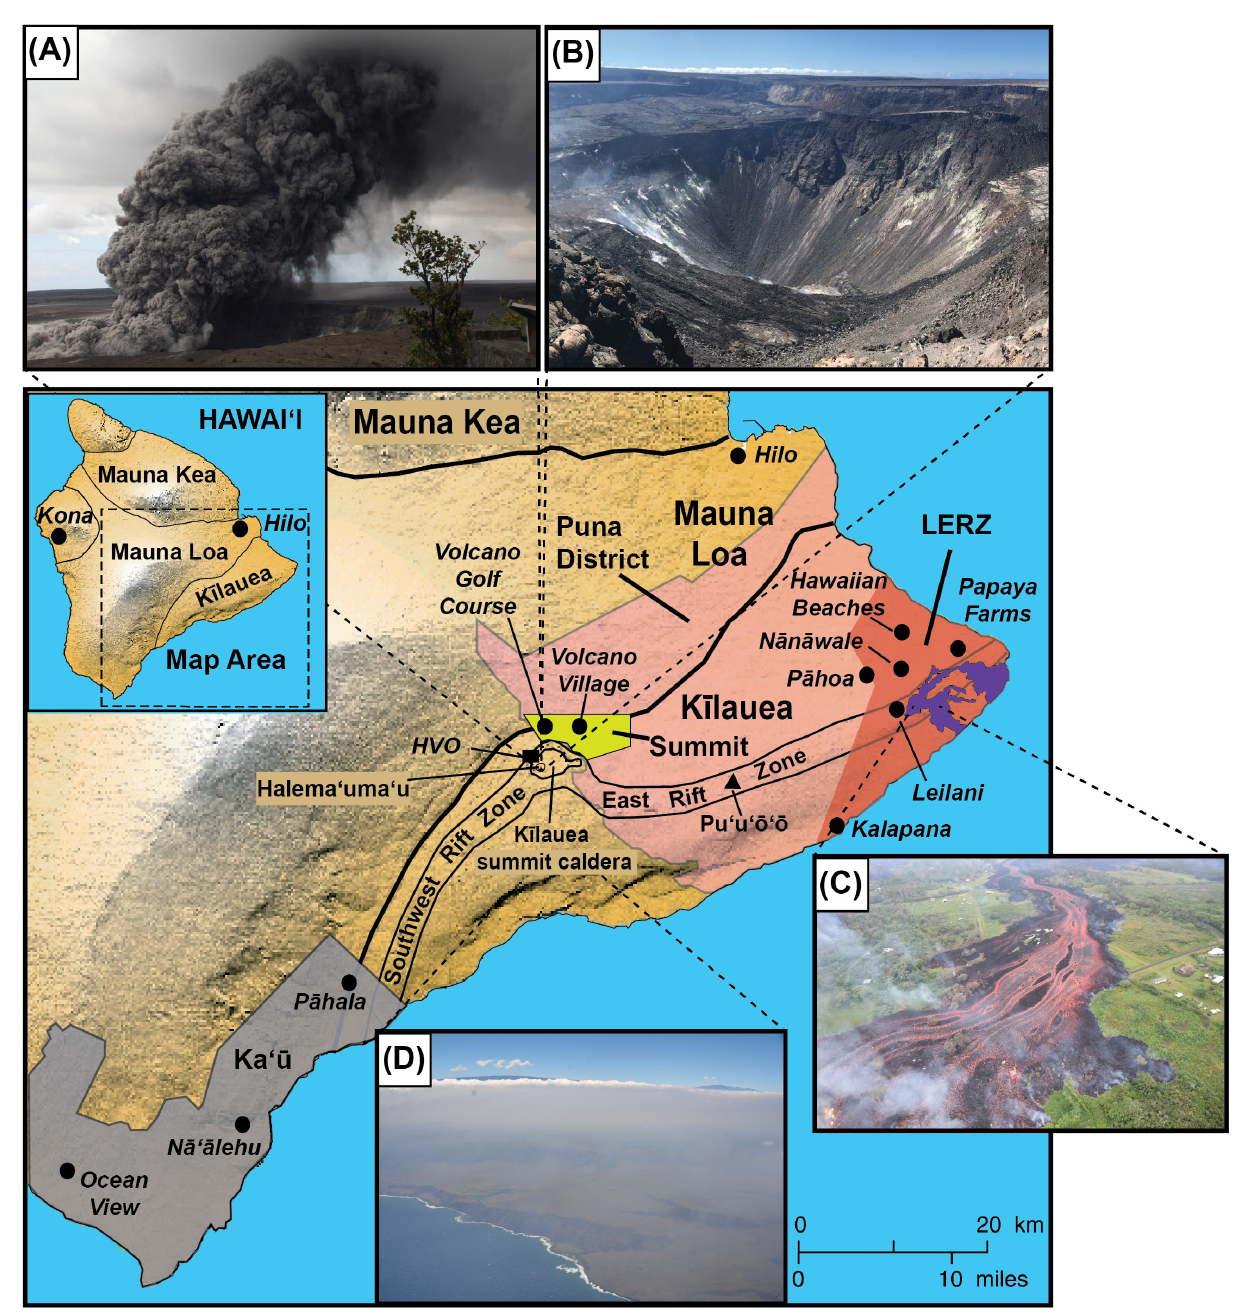
Figure 1: Map of the Island of Hawai ‘ i and images of hazards produced by K¯ılauea in 2018. Shaded polygons indicate the regions referred to in this manuscript as the Lower East Rift Zone, or LERZ (orange); summit (yellow); and Ka ‘ ¯u (gray); as well as the Puna District (pink) that includes both the LERZ and summit. HVO = USGS Hawaiian Volcano Observatory. Hazards from the 2018 eruption included [A] eruptions of ash plumes from the summit that carried ash as far as the Hawaiian Ocean View Estates, or “Ocean View” (in southwestern Ka ‘ ¯u); [B] the collapse of K¯ılauea’s summit caldera, producing earthquakes of M5.2 or larger once every ~30 hours and producing a large crater-like depression (photo taken in May 2019 by Matthew Patrick, USGS); [C] extensive lava flows that destroyed over 700 buildings in the LERZ; and [D] vog, which formed from atmospheric reactions with volcanic gas emitted from the LERZ and summit and degraded air quality throughout Hawai ‘ i. (Adapted from Tilling et al. [2010]). buried by 15–25 meters of lava [Babb et al. 2011]. From